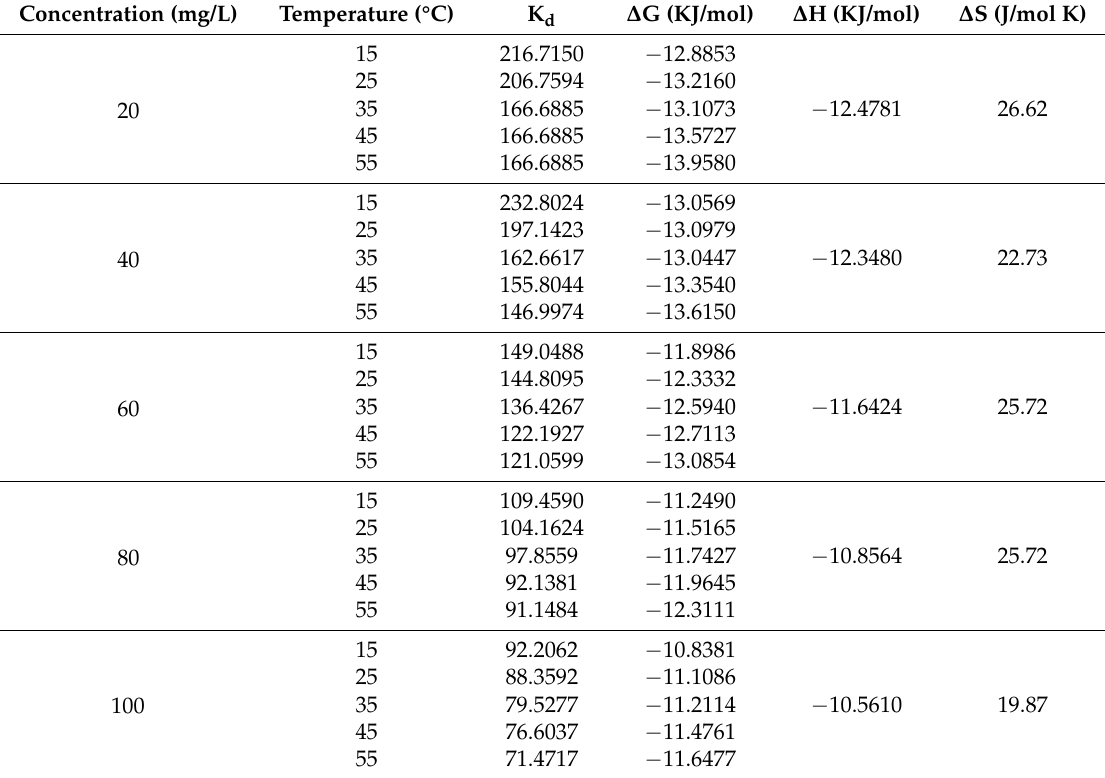
Table 3. Thermodynamic parameters for the adsorption of MB onto CNC-g-AA-2-120-8 aerogels. Concentration